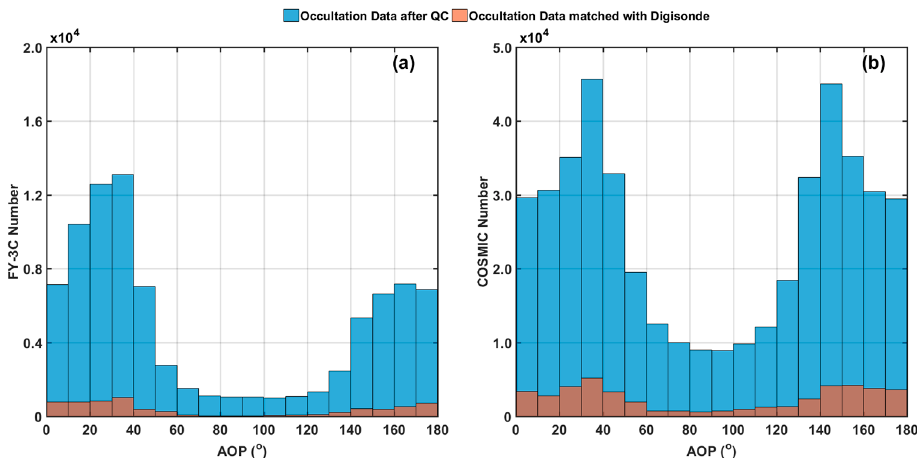
Figure 3. Distributions of the azimuth of the occultation planes (AOPs) of the qualified RO EDPs and of the RO EDPs collocated with digisonde observations for ( a ) FY-3C and ( b ) COSMIC.